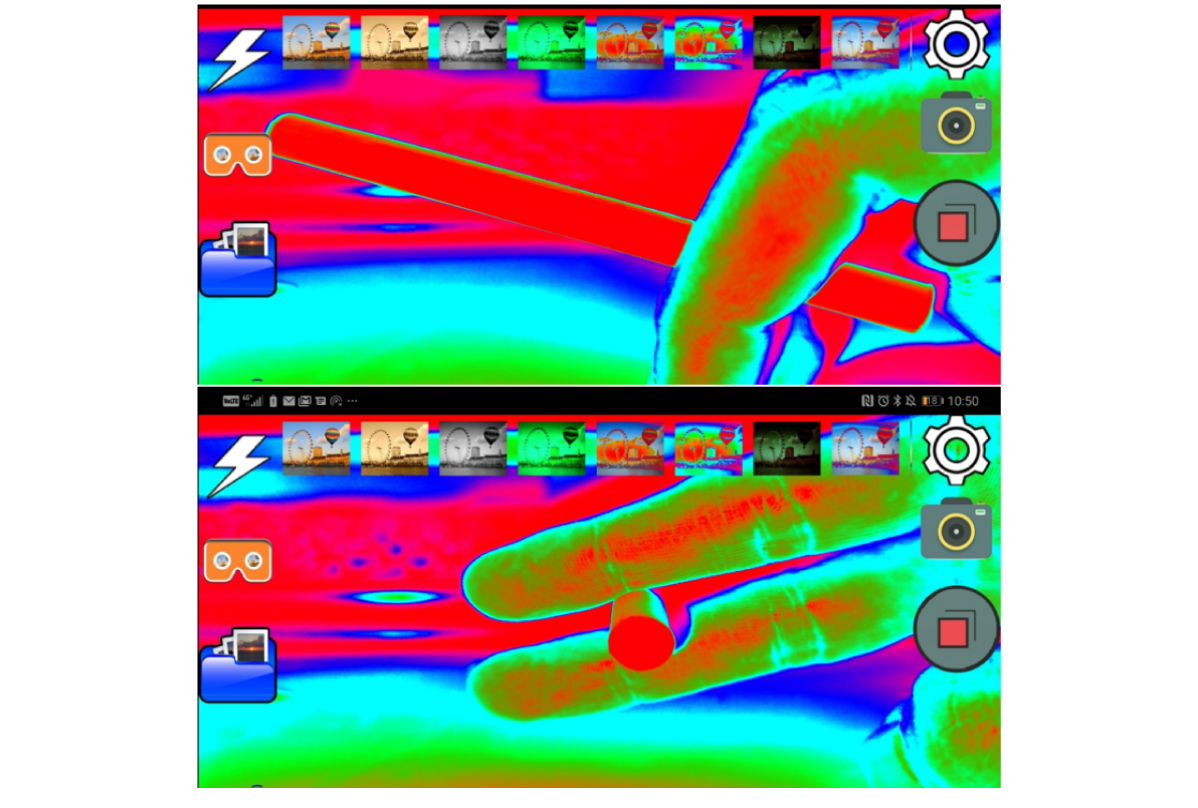
Figure 1. Screenshots of the cigarette blinding app for virtual